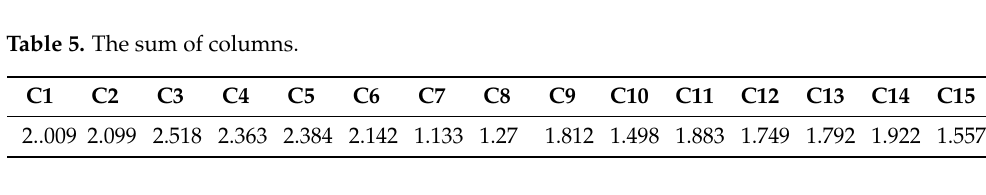
Table 6. The sum of rows and columns (D + R).